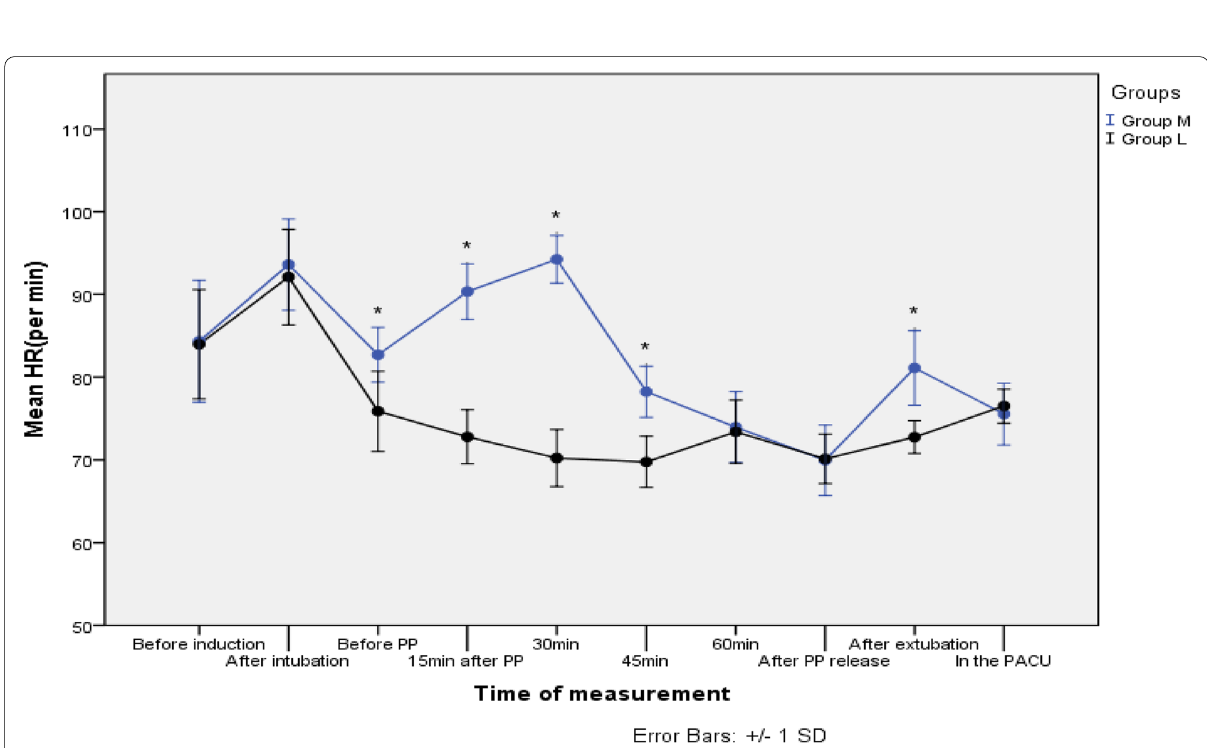
Fig. 4 Heart rate (HR) at different times of